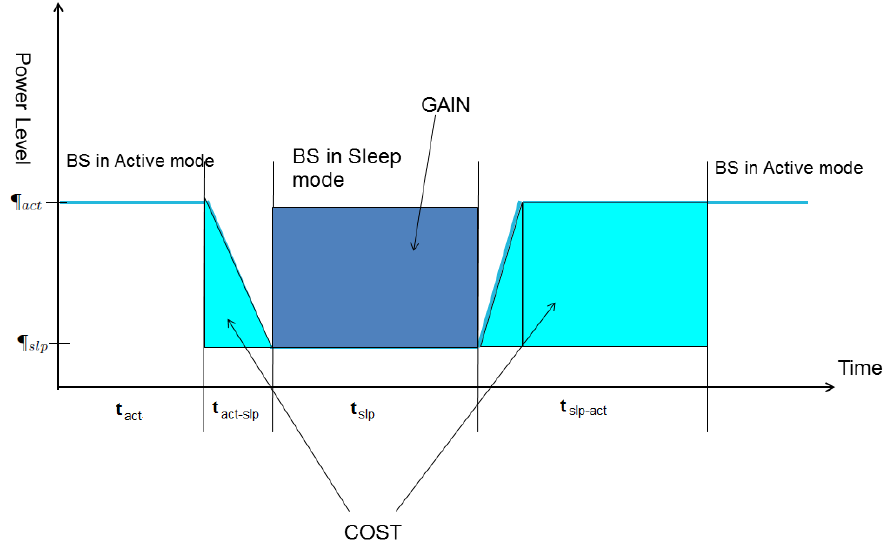
Figure 2. Graphical representation of energy saving and energy wasting due to activating BS from sleep mode.